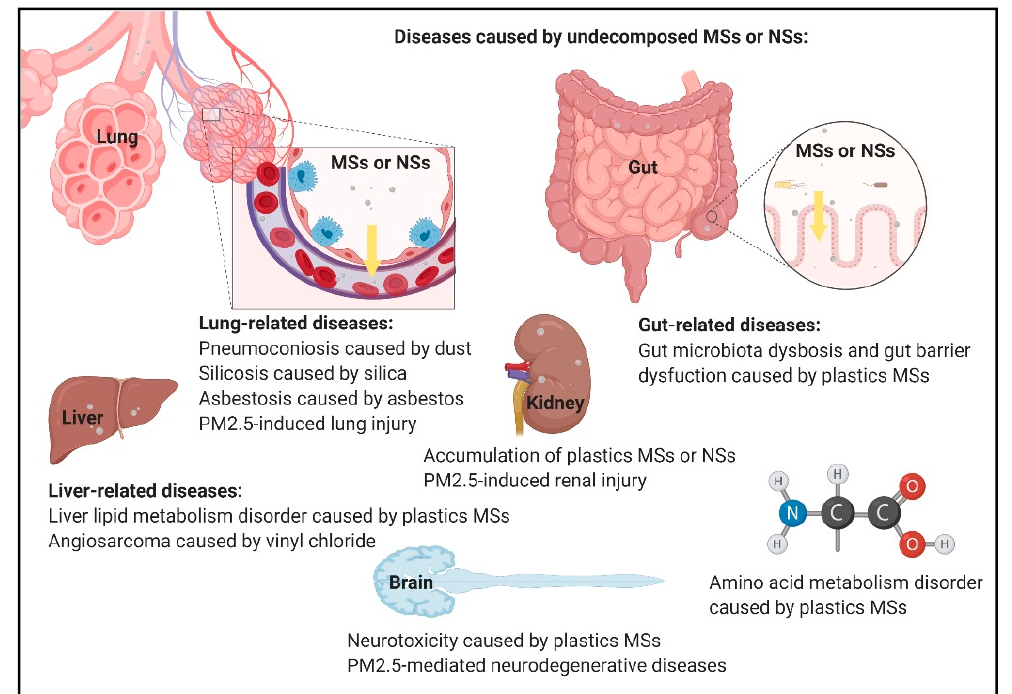
Figure 3. Schematic picture of undecomposed MSs and NSs causing diseases. MSs and NSs can cause obstruction, inflammation, and accumulation in organs. MSs and NSs, such as dust, silica, asbestos, plastics MSs, and PM2.5, have been found to be related to diseases in previous studies.